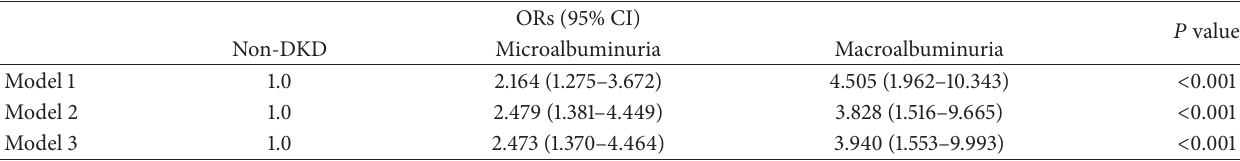
Table 4: Adjusted ORs and 95% CIs for LHV according to